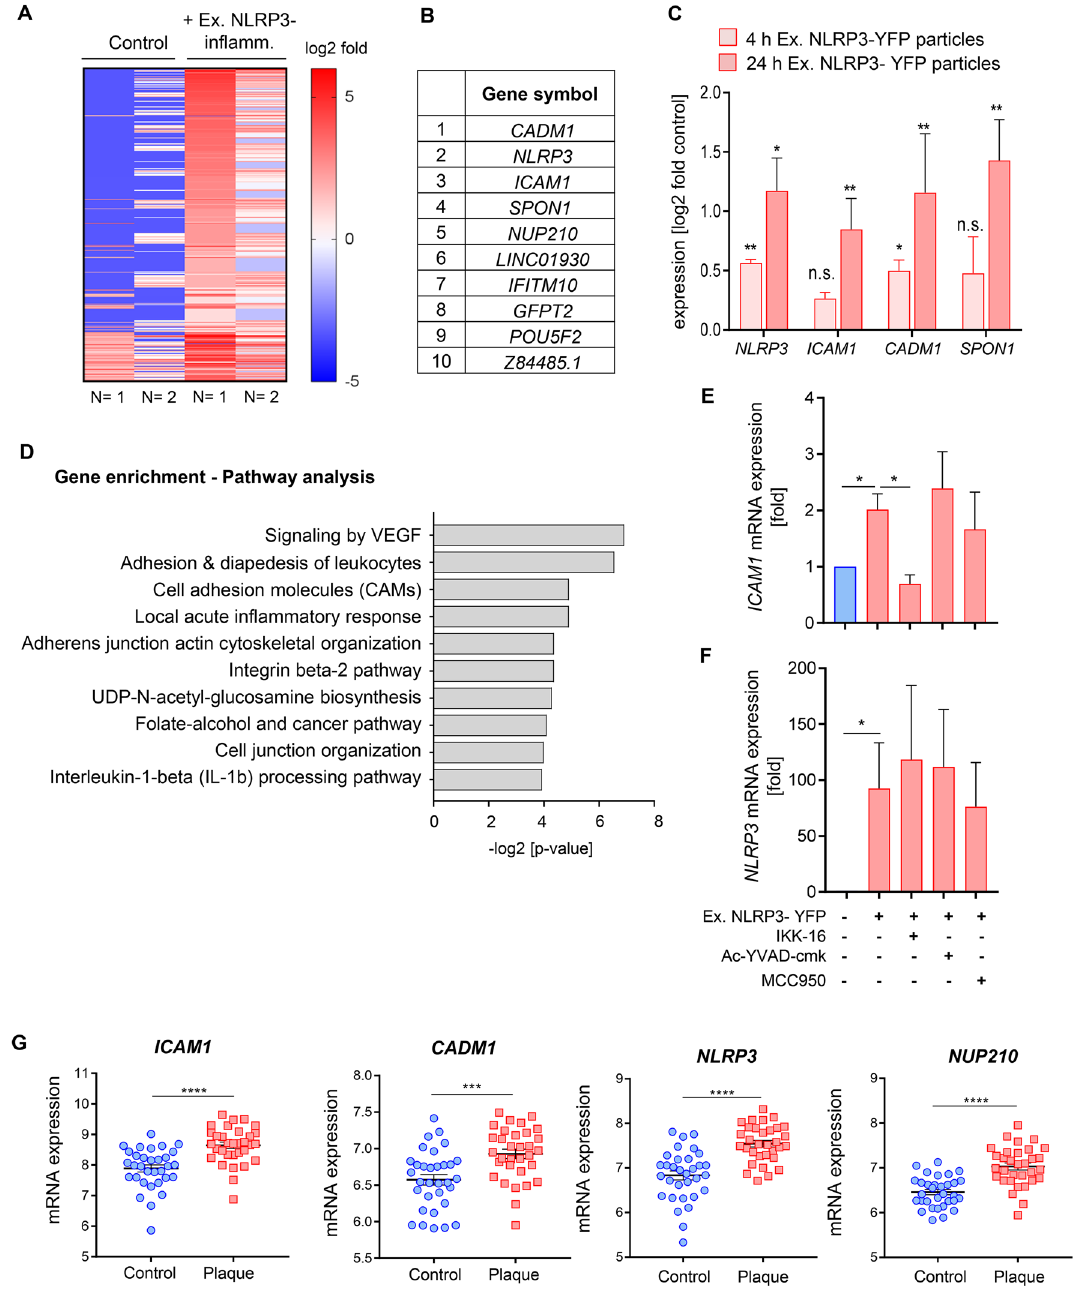
Figure 2. Extracellular NLRP3-YFP inflammasome particles regulate gene expression in HCASMC. (A) Heatmap of genes upregulated in HCASMC treated with extracellular NLRP3-YFP inflammasome particles (N = 2) for 24 h. ( B) List of the ten most upregulated genes. ( C) Validation of four listed genes ( NLRP3 , ICAM1 , CADM1 , SPON1 ) using qPCR after 4 and 24 h treatment with extracellular NLRP3-YFP particles. Data were normalized on the mean of two housekeeping genes ( RPLP0 and TBP ) and were log2-transformed for equal distribution. Untreated cells (control) were set at 1. ( D) Gene enrichment analysis of the 200 most upregulated genes (mean log2 fold > 3.5 vs. control) was performed using EnrichR and NCATS BioPlanet 2019 comprehensive integrated pathway analysis. Pathways with p < 0.05 are shown. mRNA expression of ( E) adhesion molecule ICAM1 and ( F) NLRP3 in HCASMC (N = 9) treated with extracellular NLRP3-YFP inflammasomes (3:1 particles/ cell) for 24 h with or without pre-incubation of caspase-1 inhibitor (Ac-YVAD-cmk, 25 µg/ml), NLRP3 inhibitor (MCC950, 1 µM) and NFκB inhibitor (IKK-16, 2 µM). Data are expressed as mean ± SEM and were normalized on the mean of two housekeeping genes ( RPLP0 and TBP ) and referenced to untreated control which was set at 1 . Differences between the groups were calculated using One-way ANOVA and uncorrected Fisher´s LSD post-hoc test (* p < 0.05). ( G) Selected genes ( NLRP3 , ICAM1 , CADM1 , NUP210 ) were re-analysed using a pre-existing microarray dataset and the gene expression was compared between atheroma plaque and adjacent macroscopically intact tissue from the same patient (N = 34). Data are expressed as mean ± SEM and differences between the groups were calculated using unpaired, two-tailed Student´s T-Test (***p < 0.001, ****p <